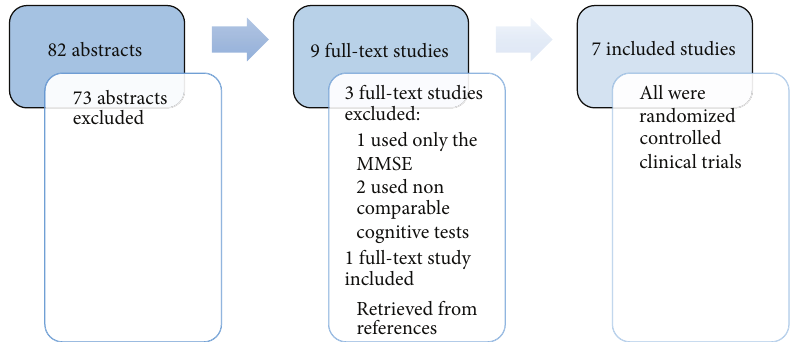
Figure 1: Summary of database search conducted on PubMed and details of study